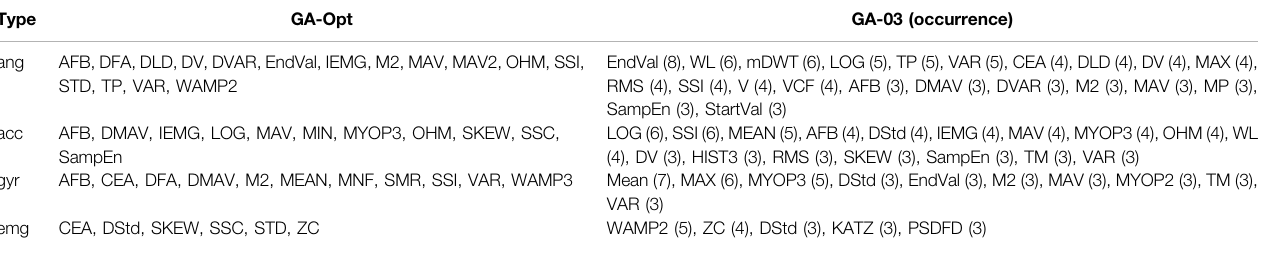
TABLE 3| Selected features ofGA-Opt and GA-03 foreach datatype. The occurrence ofthefeaturesisgiven after each feature for GA-03.Featurede fi nitionscan befound in Table 1 .